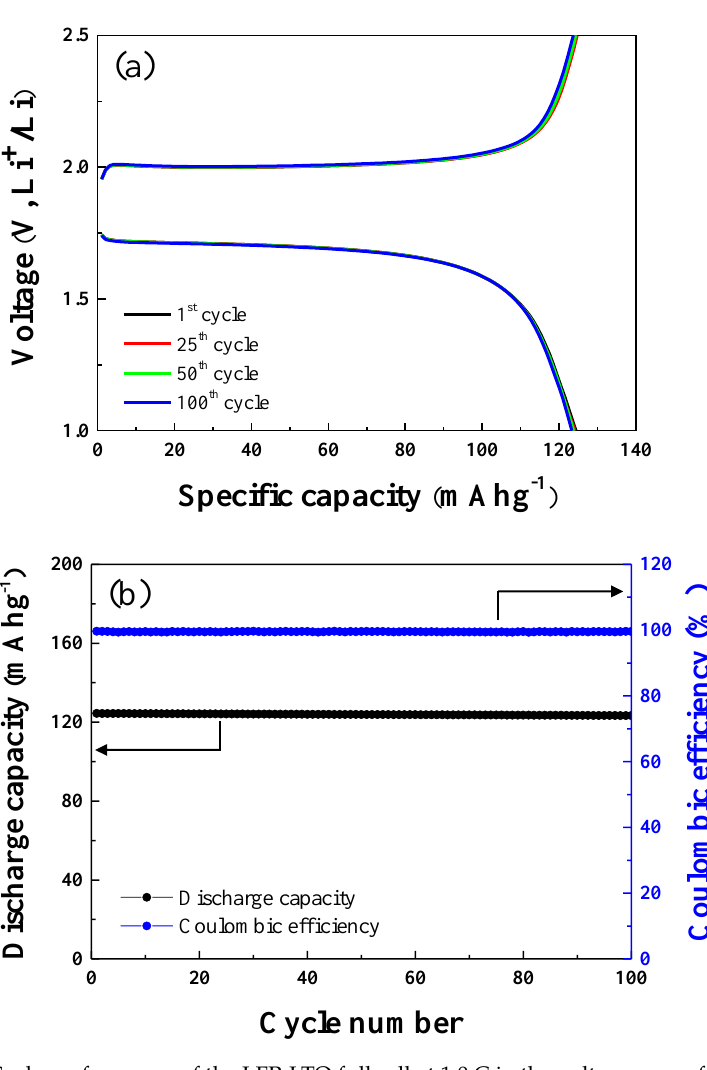
Figure 5. ( a ) Cycle performance of the LFP-LTO full cell at 1.0 C in the voltage range from 1.0 to 2.5 V for 100 cycles. ( b ) Discharge cycle retention and Coulombic efficiency for 100 cycles. Nanomaterials 2020 , 10 , x FOR PEER REVIEW